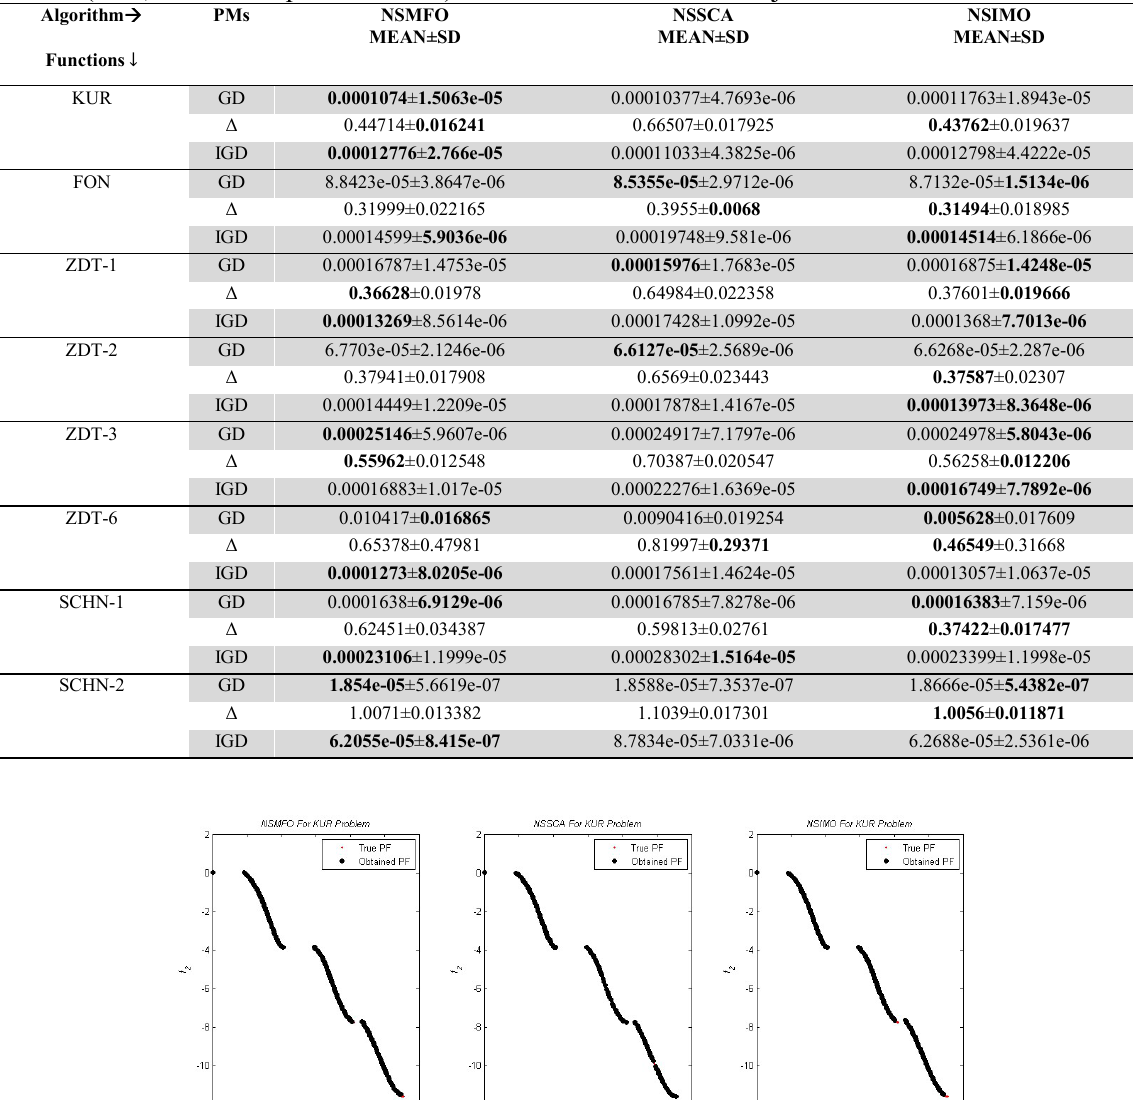
Results (IGD, Metric of Spread and GD) on Unconstrained Multi-Objective